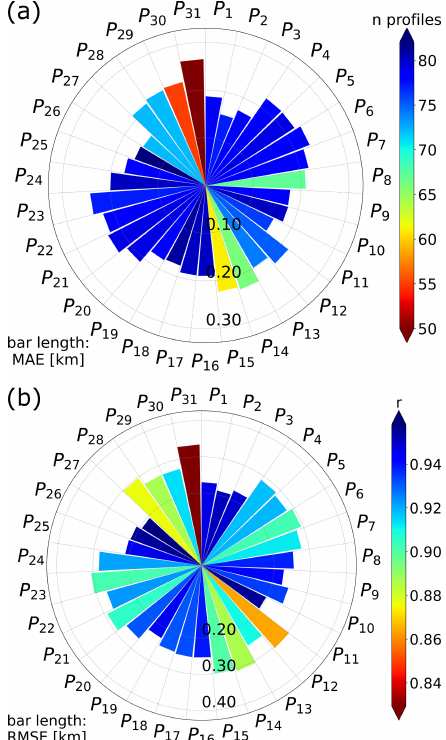
Figure 8. Errors in the ML detection for VPs using a ± 30min win- dow. In panel (a) , the bar length represents the MAE (in kilometres), and colour represents the number of vertical profiles with strong signatures detected by every polarimetric combination; in panel (b) , the bar length represents the RMSE (in kilometres) for every polari- metric combination, and colour represents the Pearson correlation